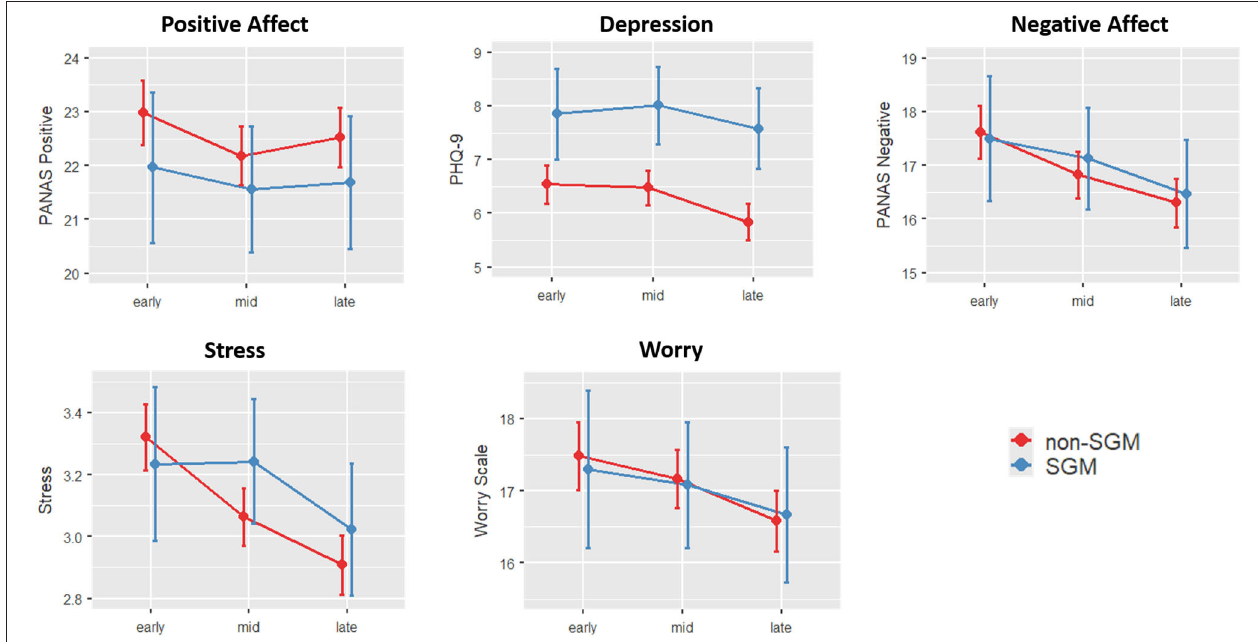
FIGURE 2 | Changes in mood and psychiatric indicators across time and groups (Model 1). Error bars show 95% confidence intervals. Depression was consistently elevated across all three time points for SGM compared to non-SGM. Stress, on the other hand, was differentially affected early on ( p = 0.028), such that non-SGM reported decreased stress from early to mid, and SGM didn’t report a reduction in stress until the late time point.